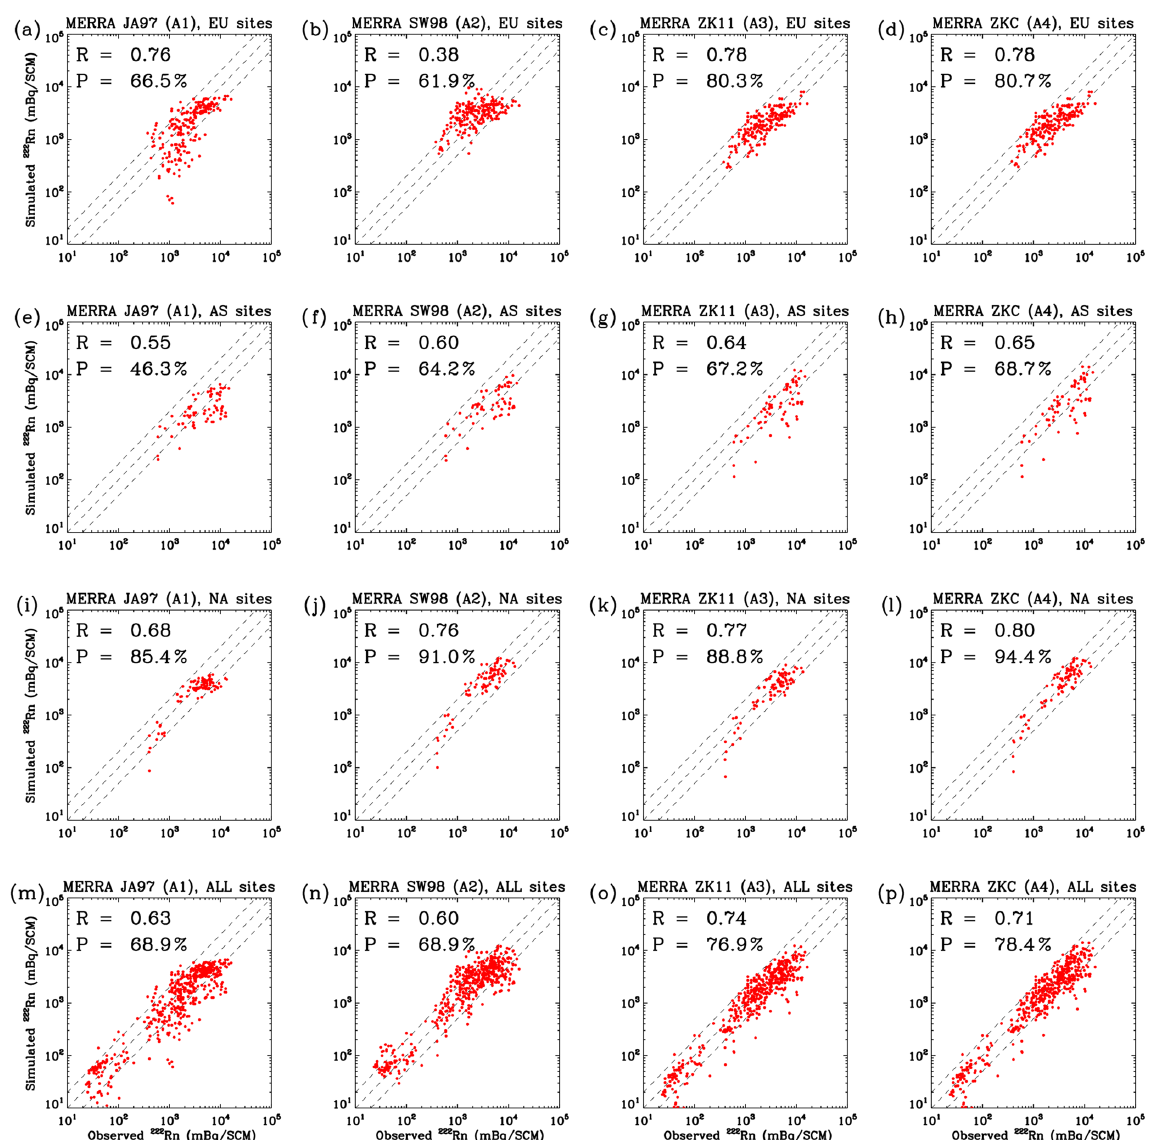
Figure 6. Comparisons between simulated and observed monthly surface 222 Rn concentrations (mBq/SCM) over the continents of Europe (EU, first row), Asia (AS, second row), and North America (NA, third row) and over the globe (ALL, last row), respectively. The four columns correspond to simulations (A1–A4) with the four emission inventories (JA97, SW98, ZK11, and ZKC; see Table 2). Dashed lines indicate the range within a factor of 2 of the 1-to-1 line. P is the percentage of samples within this range. R in the legends is the two-sided linear regression correlation coefficient. The lines of best fit are calculated using the reduced major axis method (Hirsch and Gilroy,